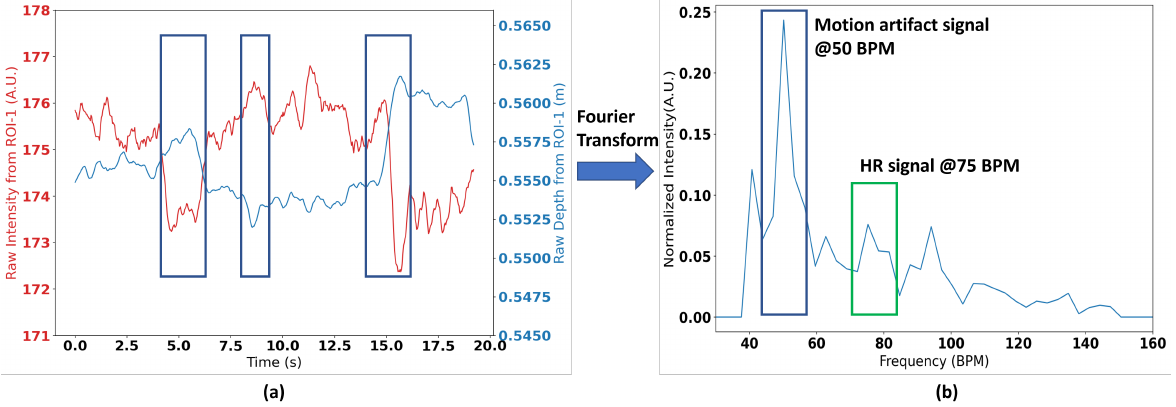
Figure 3. ( a ) Raw intensity (red) and depth (blue) captured by the ToF camera. Depth change induced by motion (blue rectangle) is inversely proportional to the intensity, which is a key source of erroneous HR reading. ( b ) When motion artifacts are present, they create artifact frequency components that overwhelm the actual HR